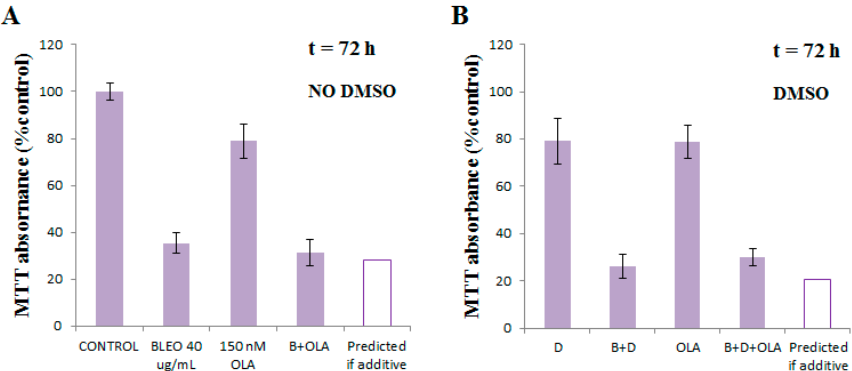
Figure A2. Concentrations of 150 nM OLA and BLEO. A single experiment was carried out to explore whether an increase in OLA concentration would lead to potentiation. Effect of combined 150 nM OLA and 40 µg/mL BLEO in the absence ( A ) or presence ( B ) of DMSO on VERO cell viability was evaluated using MTT (72 h). Mean ± SD. n = 6. Since the predicted additive effect according to Webb’s equation [25] was equal or lower than the combined effect, synergism was discarded.